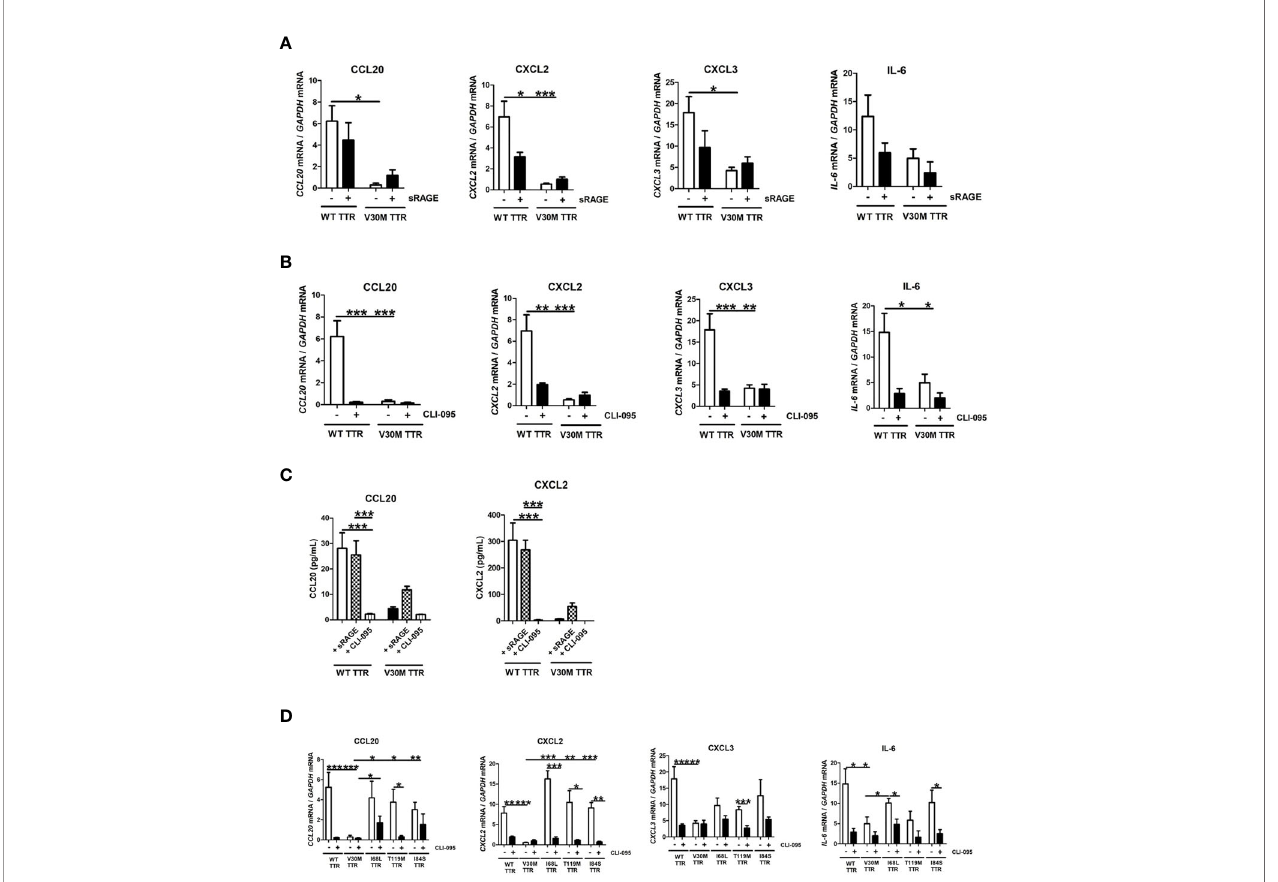
FIGURE 4 | WT TTR activates TLR4 signaling pathway and V30M TTR fail to do so. RNA was extracted from SCs incubated with WT and V30M TTR in the presence of TLR4 (A) and RAGE (B) antagonist and denoted a downregulation in the expression of several chemokines in SCs incubated with WT TTR but not in SCs incubated with V30M TTR. (C) Decreased concentration levels of CCL20 and CXCL2 in the supernatant of SCs incubated with WT TTR in the presence of TLR4 antagonist. (D) SCs were incubated with pathological and non-pathological mutations in the presence of TLR4 antagonist and the inhibition of this receptor reduces the expression of some chemokines. Data were analyzed using one-way ANOVA followed by Bonferroni post-test and represented as mean ± s.e.m (*P < 0.05; **P < 0.01; ***P <